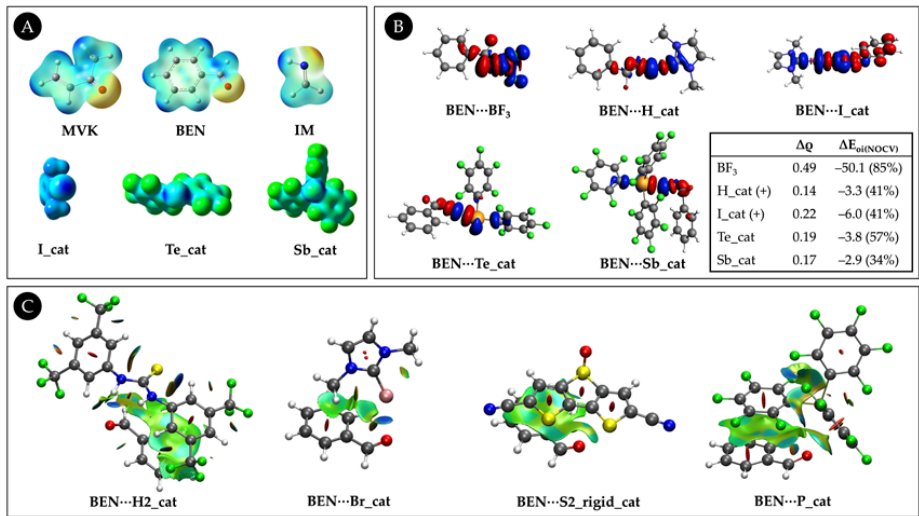
Figure 2. ( A ) Molecular electrostatic potential plots of the dienophiles and three catalysts taken at an electron density isovalue of 0.01 a.u. and with yellow–red colors denoting electron-rich regions and blue denoting electron-poor regions. ( B ) NOCVs for the catalyst-benzaldehyde complexes with corresponding ∆E oi(NOCV) in kcal mol −1 and ∆ρ values in a.u. for an isovalue of 0.0005. The values between brackets for the ∆E oi(NOCV) correspond to their relative contribution to the total orbital energies. Electron depletion is indicated in red, whereas electron accumulation is indicated in blue. ( C ) Visualization of the non-covalent interaction index (NCI) of benzaldehyde and four catalysts. Green indicates π - π and Van der Waals interactions, blue strong non-covalent bonds and red repulsive interactions such as ring